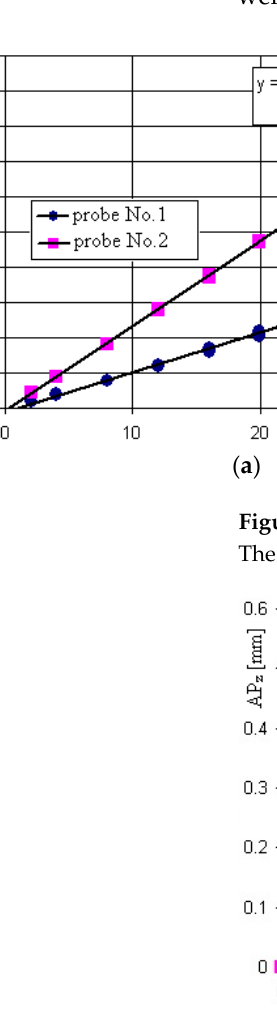
Figure 8. Positioning accuracy along the z -axis AP z = f ( β ) for Probe 1 and Probe 2, Sample